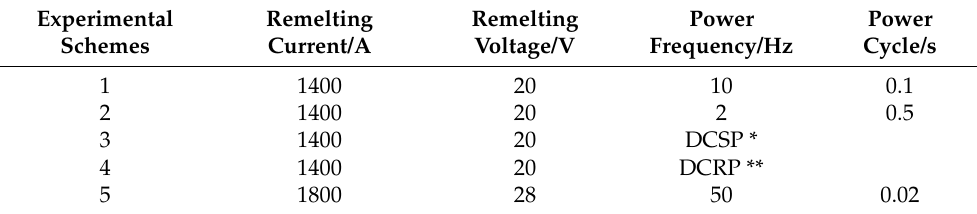
Table 2. Experimental schemes.